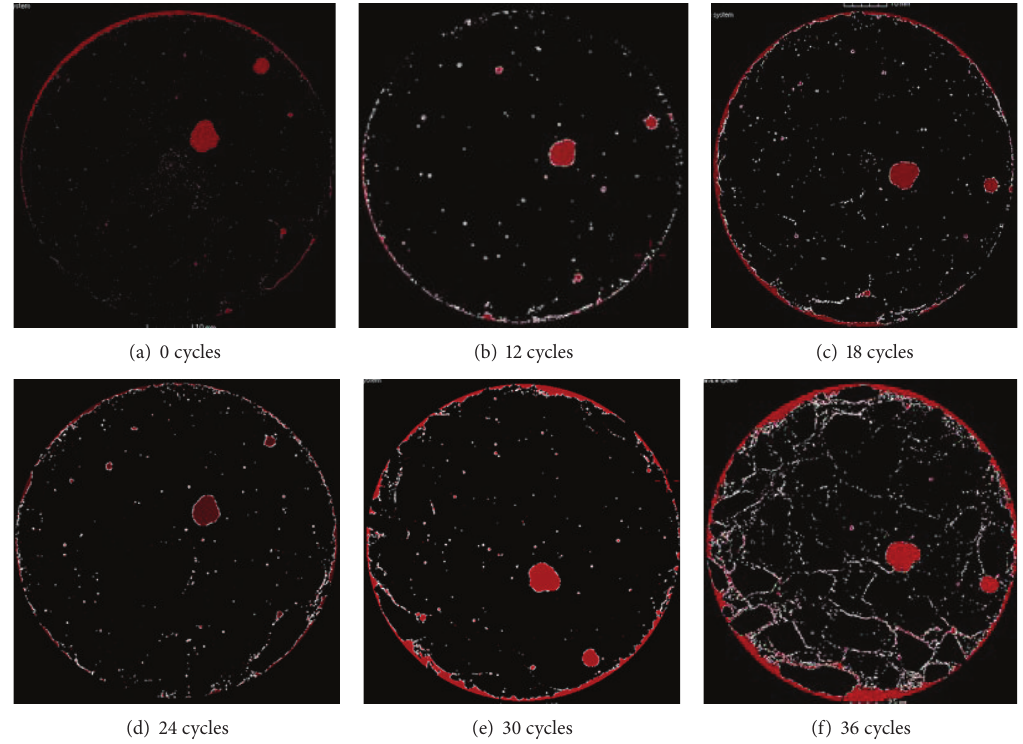
Figure 13: Damage process of the lower section under different cycles of